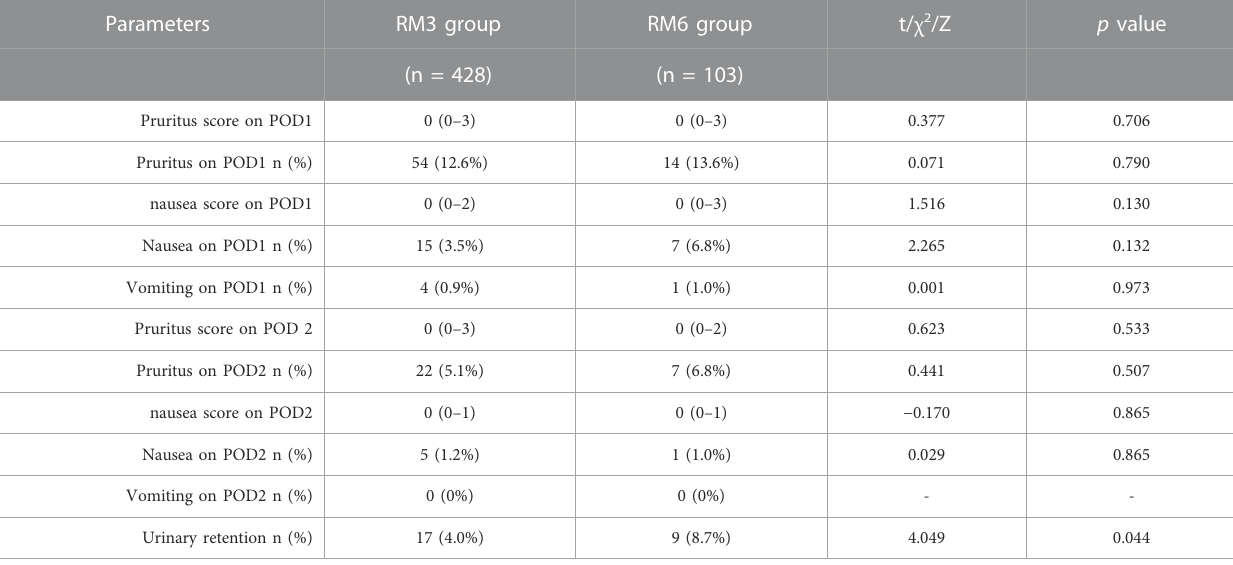
TABLE 3 Incidence, severity score, and distribution of reported motor weakness and side effects in the RM3 and RM6